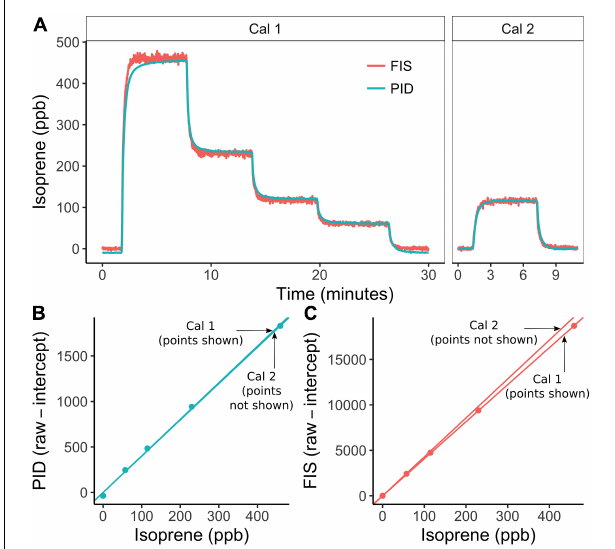
FIGURE 5 | Inter-comparison between the photoionization detector (PID) employed in PORCO and the Fast Isoprene Sensor (FIS) shows comparable precision and signal stability in response to isoprene calibration gas. The PID sampled from an upstream gas mixture, while the FIS sampled from the PID exhaust. (A) Response of each instrument to dilutions of isoprene standard used to produce the calibration curves in (B,C) . The instrument responses in (A) are visualized in calibrated units of ppb so that instrument signals are aligned and their agreement and stability can be compared. Cal 1 was performed prior to a series of leaf samples, and Cal 2 afterward, with an elapsed time between calibrations of approximately 4 h. Points in (B,C) are 15 and 30 s averages of PID and FIS raw signals respectively, from the end of each dilution response plateau. Noise at 1 s resolution is higher in the FIS (A) , but the linearity of the FIS response (C) is slightly better than that of the PID (b). PID responsivity (slope) drifted less (B) than FIS responsivity (C) , but the FIS baseline (intercept) was more stable over time (not shown, see discussion of temporal PID drift in Main Text). ( Supplementary Figure 5 , linear regression: r 2 = 0.971, slope [PID ∼ FIS] = 0.88). The regression residuals indicating sensor of 9.7 ppb (97.5 − 2.5 percentiles), attributable primarily to